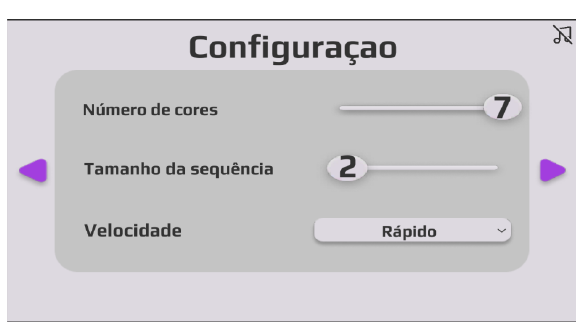
Figure 10. Ritmo Mania settings screen